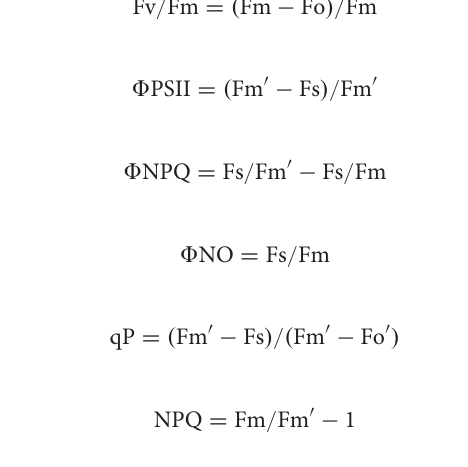
fluorescence yield (F m ’) was determined by 8,000 µ mol m − 2 s − 1 . The actinic light was turned off, and minimal fluorescence yield (F o ’) in light-adapted state was determined after 5 s of far- red illumination. The difference between the measured values of F m and F o is the variable fluorescence (F v ). The chlorophyll fluorescence parameters were calculated using the following formulas (Kooten and Snel, 1990; Maxwell and Johnson, 2000; Kramer et al.,